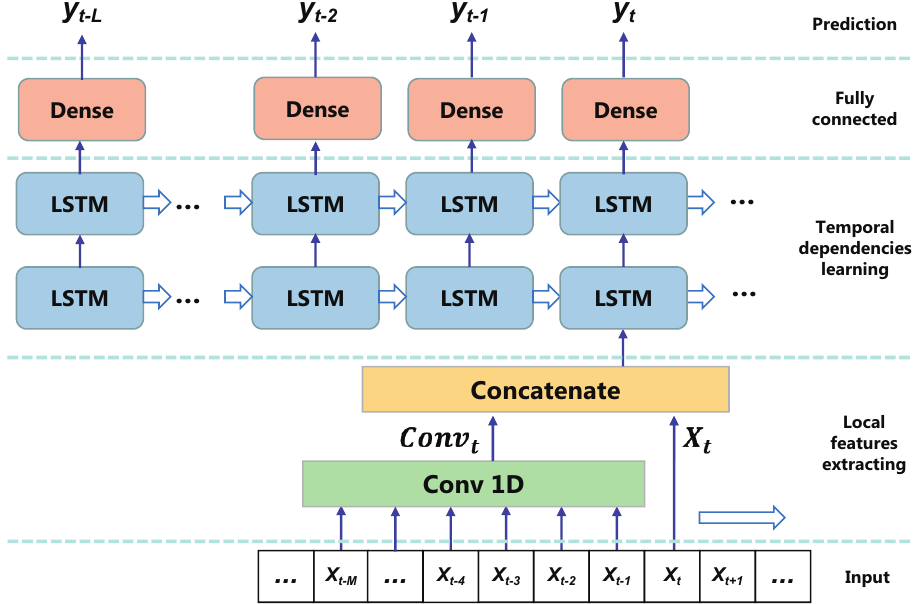
Figure 4. Structure of the proposed hybrid convolutional recurrent neural network (HCRNN) model for important trading point prediction, where detailed layer connections are